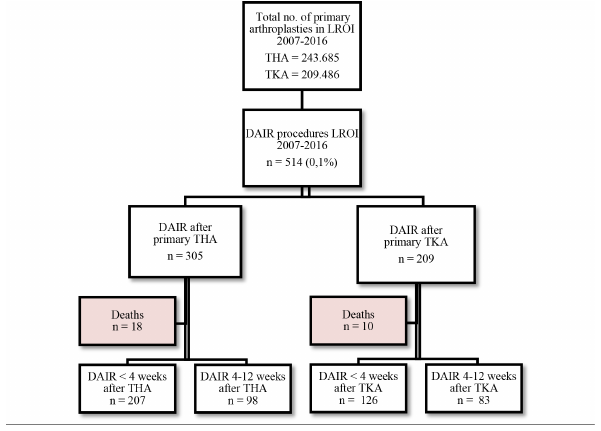
Figure 2. Trend of DAIRs (with modular component exchange) registered per year in the LROI ( x axis: year in which procedure was registered, y axis: number of DAIRs